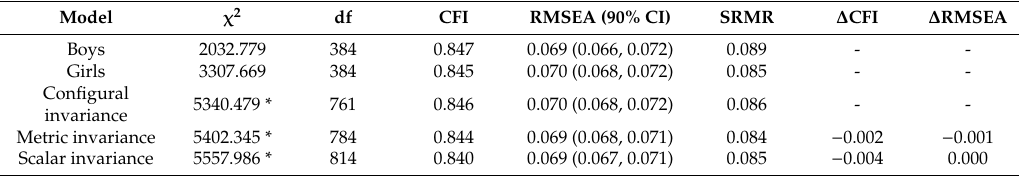
Sex invariance analyses of the Adult Eating Behavior Questionnaire (AEBQ) in Polish